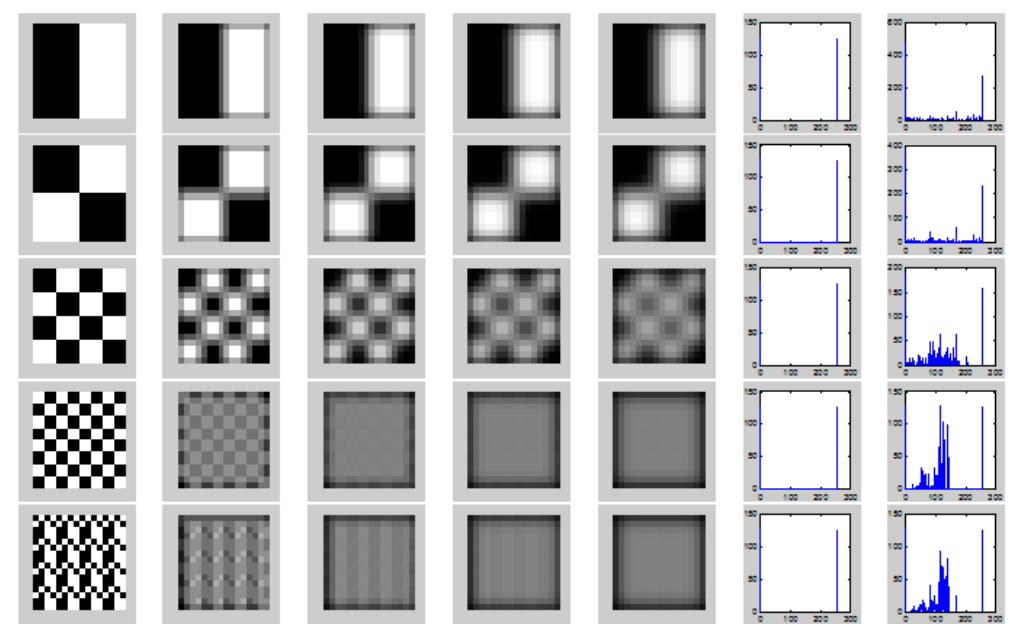
Figure 1. Different images with histograms and SCH shapes.